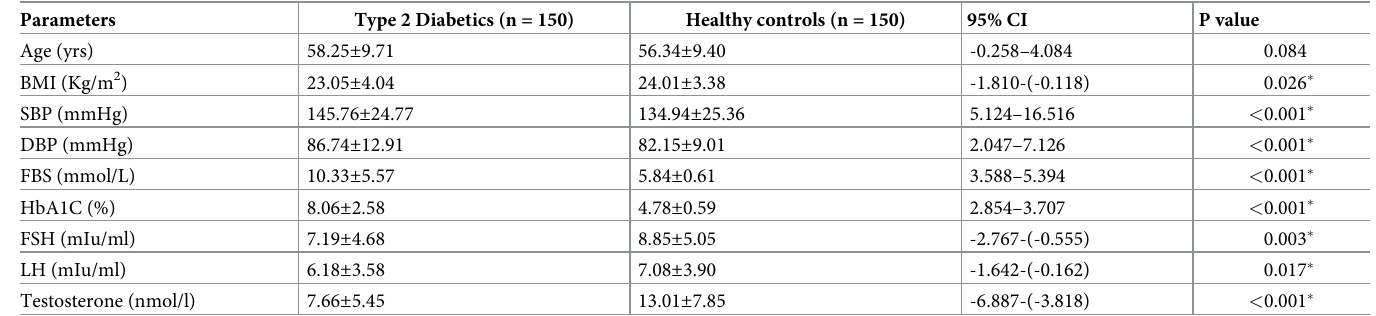
Table 2. Clinical and hormonal parameters of the study population.